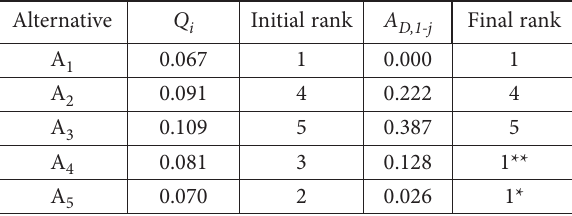
Table 11. The values of the total gaps (Scenario 1)